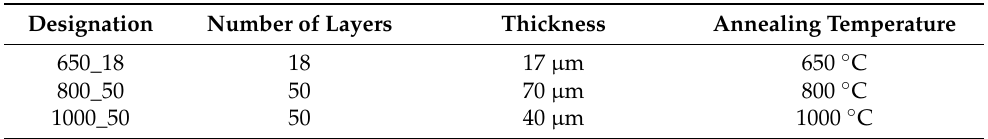
Table 1. Parameters of examined